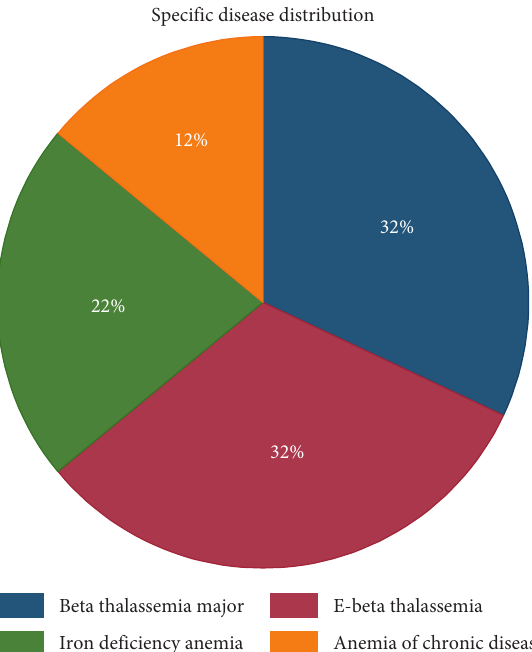
Figure 1: The distribution of the study population according to specific disease ( n �